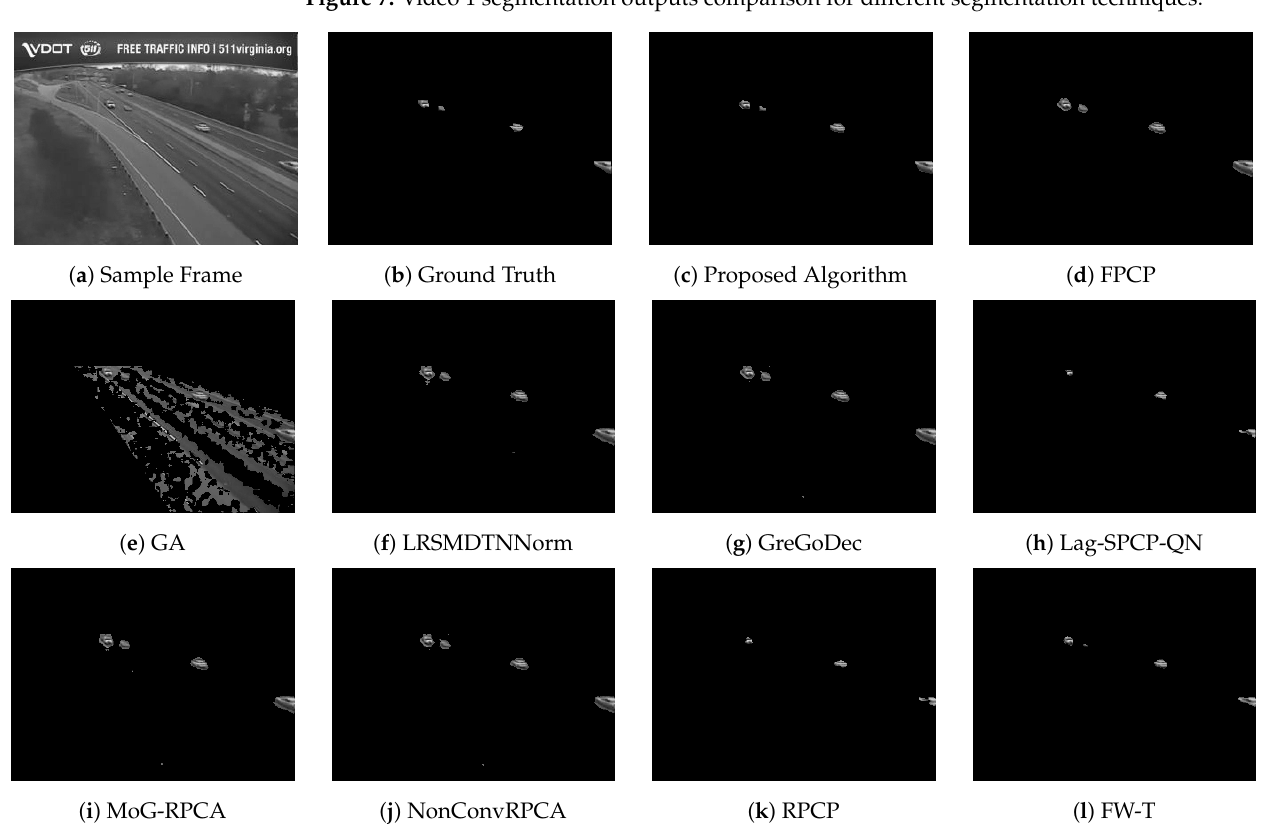
Figure 8. Video 2 segmentation outputs comparison for different segmentation